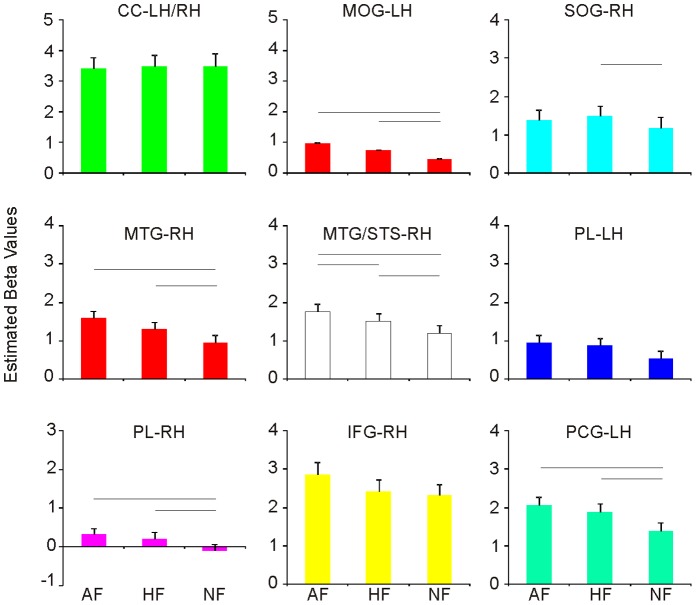
Estimated beta values for the E conditions.